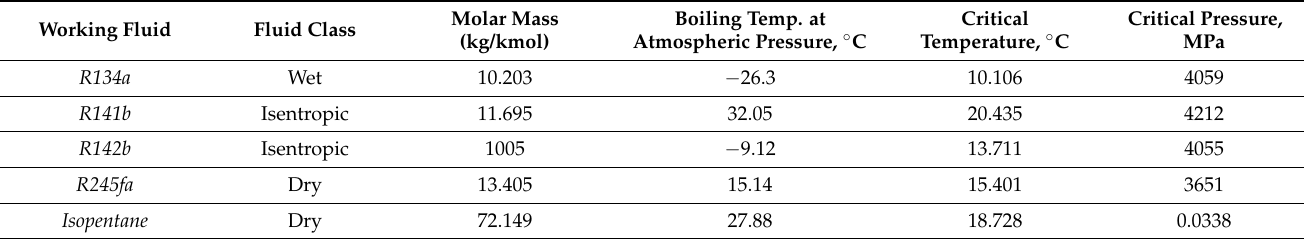
Table 3. Working fluid selection for research with main